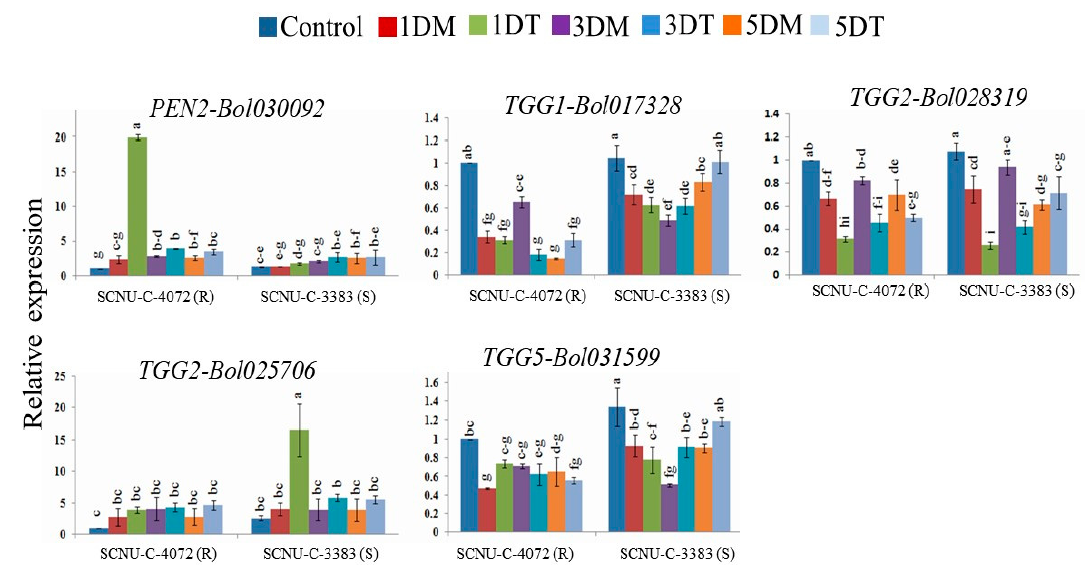
Figure 6. Relative expression of GSL breakdown related genes induced by myrosinase enzyme in the black rot resistant (SCNU-C-4072) and susceptible (SCNU-C-3383) cabbage lines at di ff erent days after inoculation (1, 3, and 5 DAI) using Xcc pathogen under di ff erent treatment conditions (C, control; 1DM, 1 day mock; 1DT, 1 day treated; 3DM, 3 day mock; 3DT, 3 day treated; 5DM, 5 day mock; 5DT, 5 day treated) compare to mock-treated leaves. Vertical bars indicate the standard deviation. Di ff erent letters indicate statistically significant di ff erences ( p < 0.01) between genotypes (R: SCNU-C-4072 and S: SCNU-C-3383) lines and treatment interactions following Tukey test. R, resistant; S, susceptible.